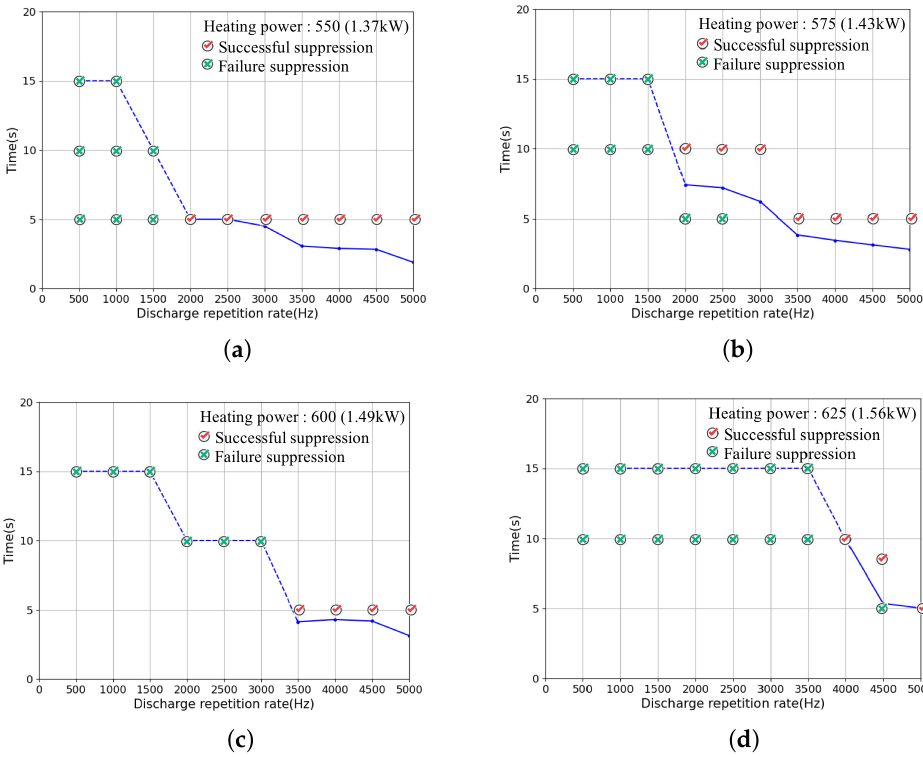
Figure 8. Experimental groups at different heating powers (every grid nodes represent an actual work setting , e.g., (3000 Hz, 10 s) means that the discharge device worked at 3000 Hz repetition rate for 10